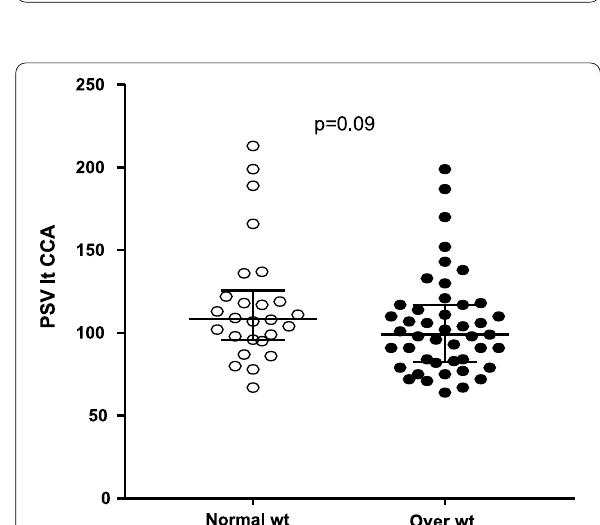
115.47 cm/s, while mean = 110.20 cm/s =